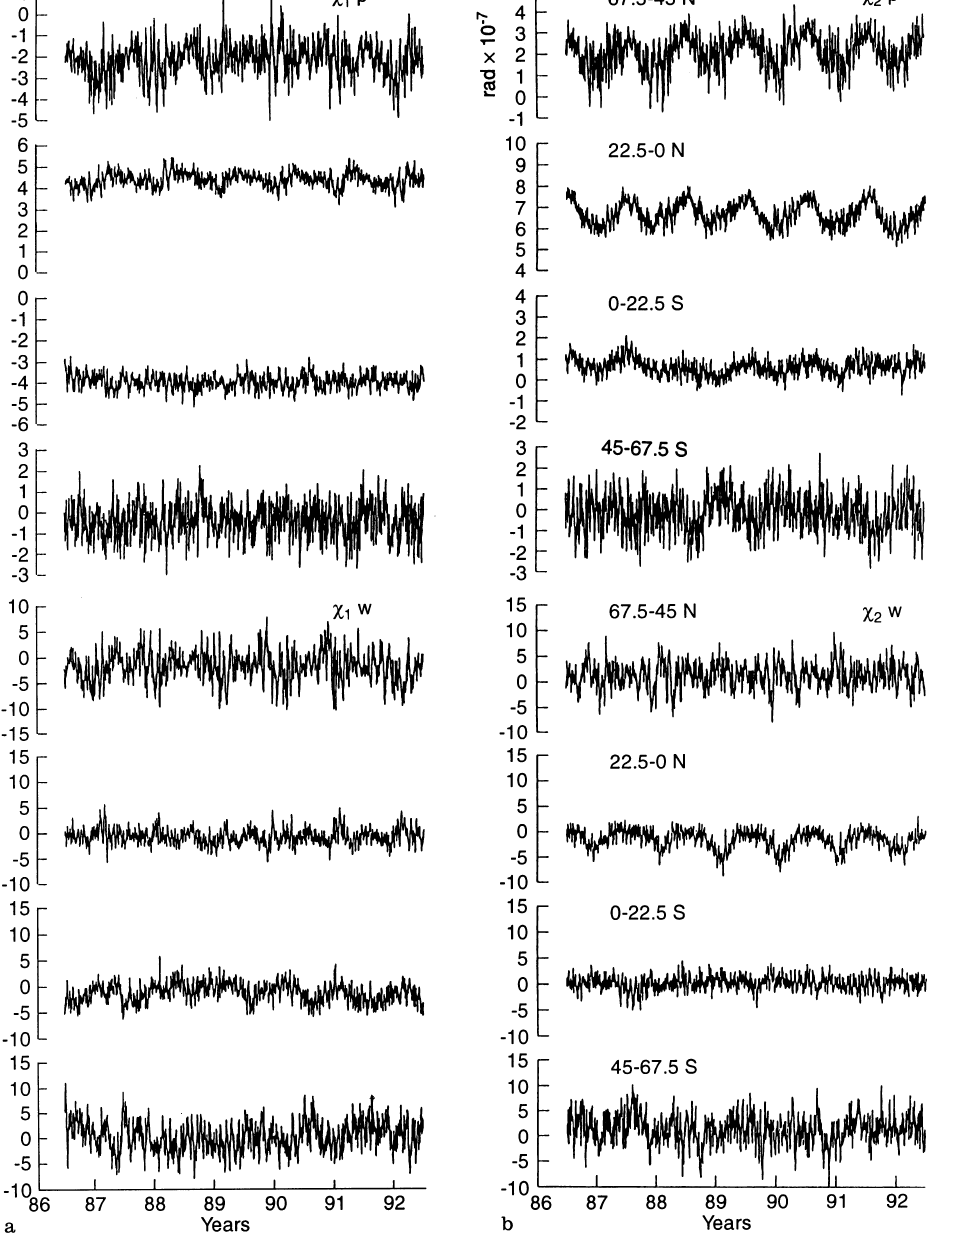
Fig. 1. Examples of variations of the a pressure and b wind (b) terms of (cid:118) and (cid:118) components of 1 2 the zonal EAAM (JMA)